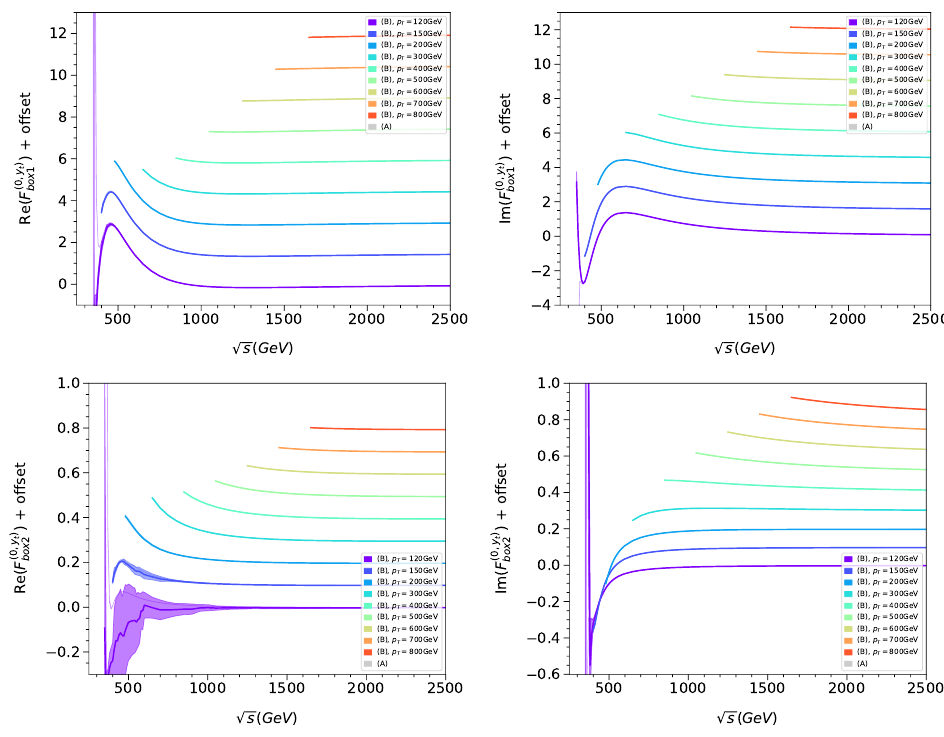
Figure 9 . Real and imaginary parts of F box1 and F box2 for fixed p T . Note that an offset is applied such that the curves for the different p T values are clearly separated. No offset is used for the lowest p T value. For F 1 ( F 2 ) we shift the subsequent p T curves by 1.5 (0.1) in the positive y axis direction. The coloured curves and the corresponding bands correspond to approach (B). Results for approach (A) are only shown as faint uncertainty bands. For p T ≥ 150 GeV the central values of approach (A) and (B)